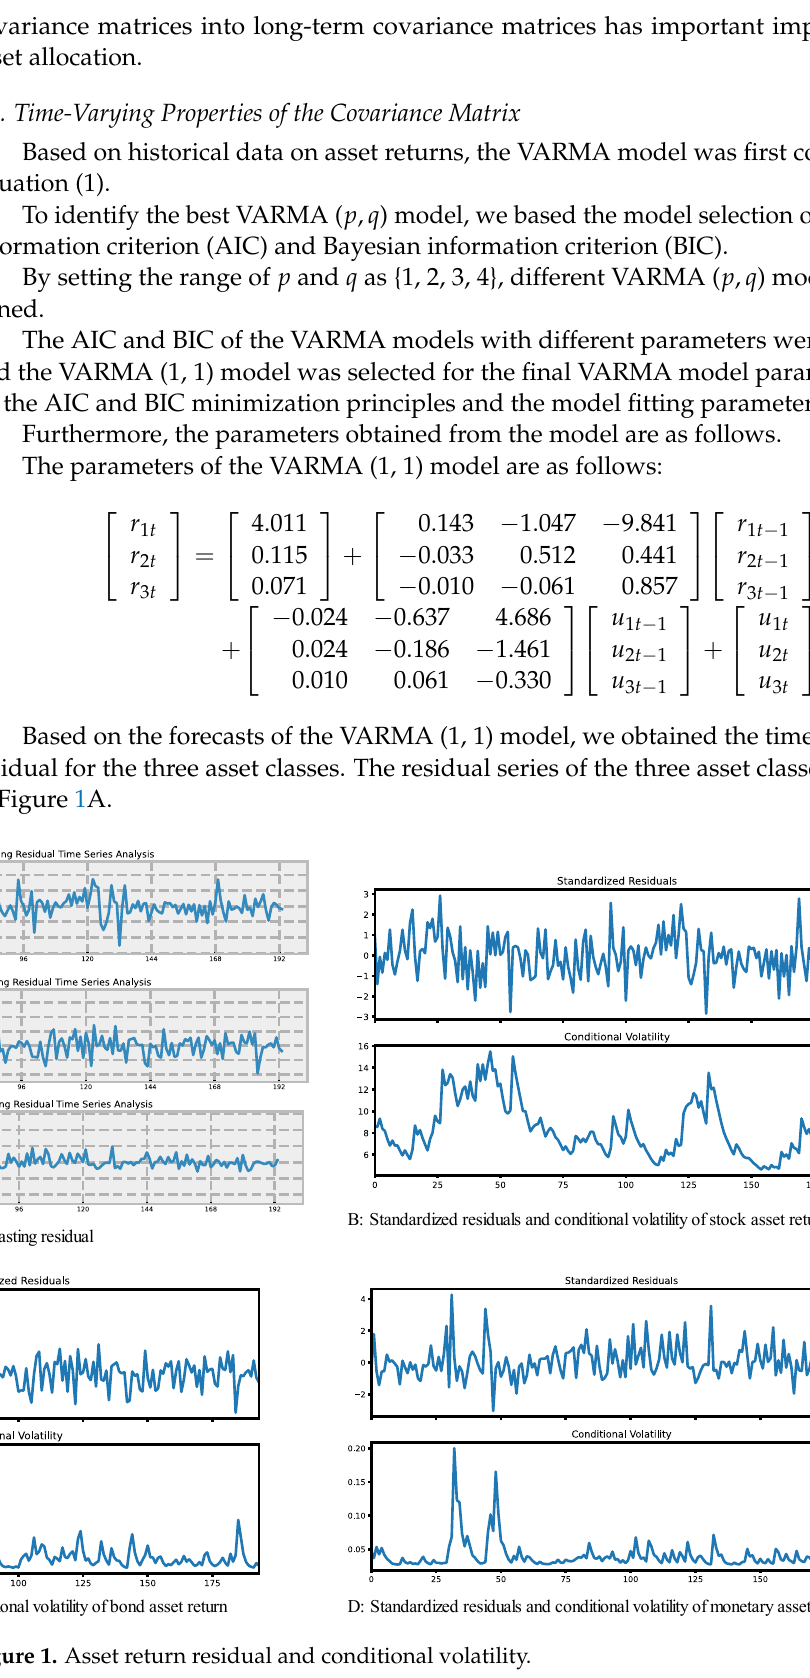
Figure 1. Asset return residual and conditional volatility.